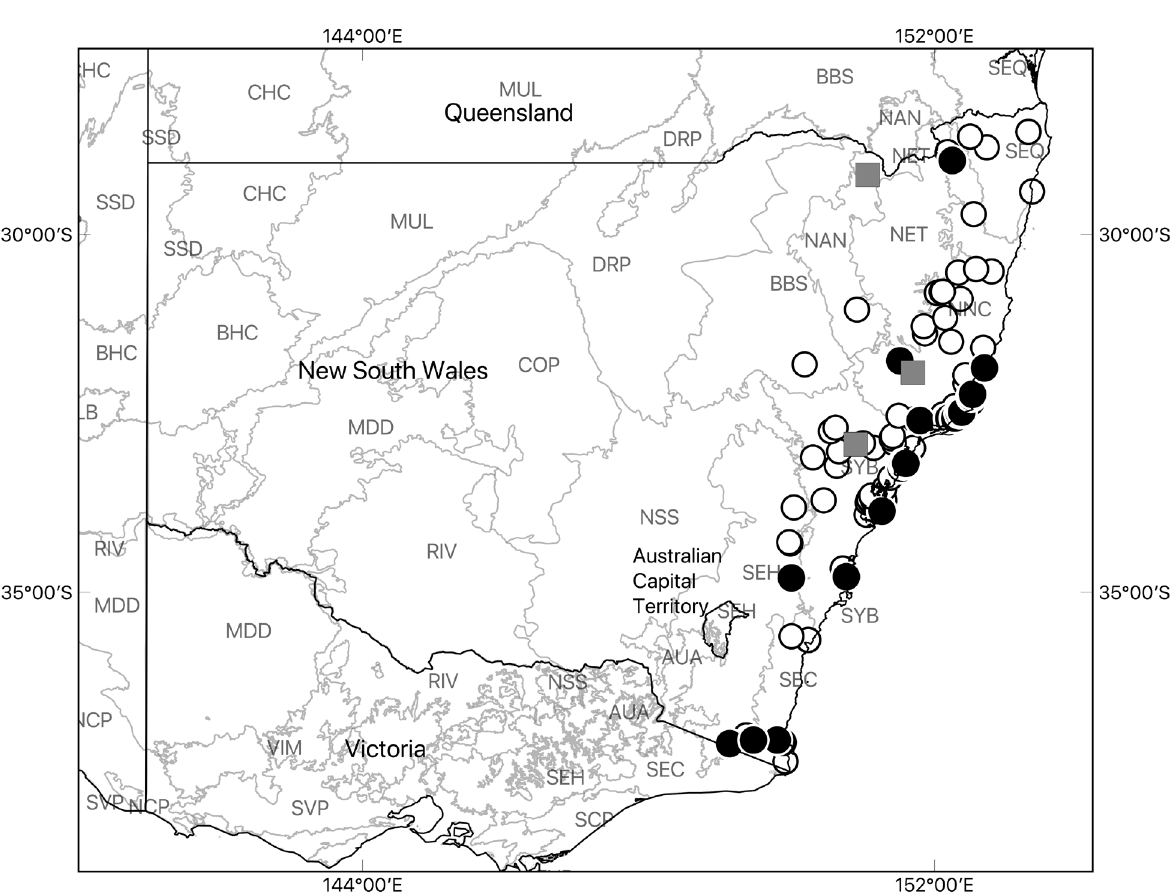
Figure 23. Distribution records of Artoria grahammilledgei sp. n. (open circles), A. helensmithae sp. n. (full circles) and A. howquaensis Framenau, 2002 (grey squares) in NSW. IBRA bioregions with spider records: BBS – Brigalow Belt South; NAN – Nandewar; NET – New England Tablelands; NNC – NSW North Coast; SEQ – South East Queensland; SEH – South Eastern Highlands; SEC – South East Corner; SYB – Sydney